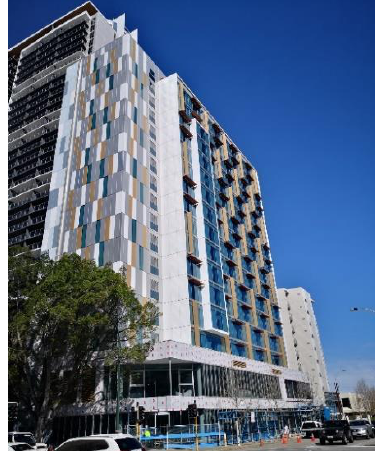
Figure 2. 18 storey modular hotel in Perth (photo by Y. Sun).